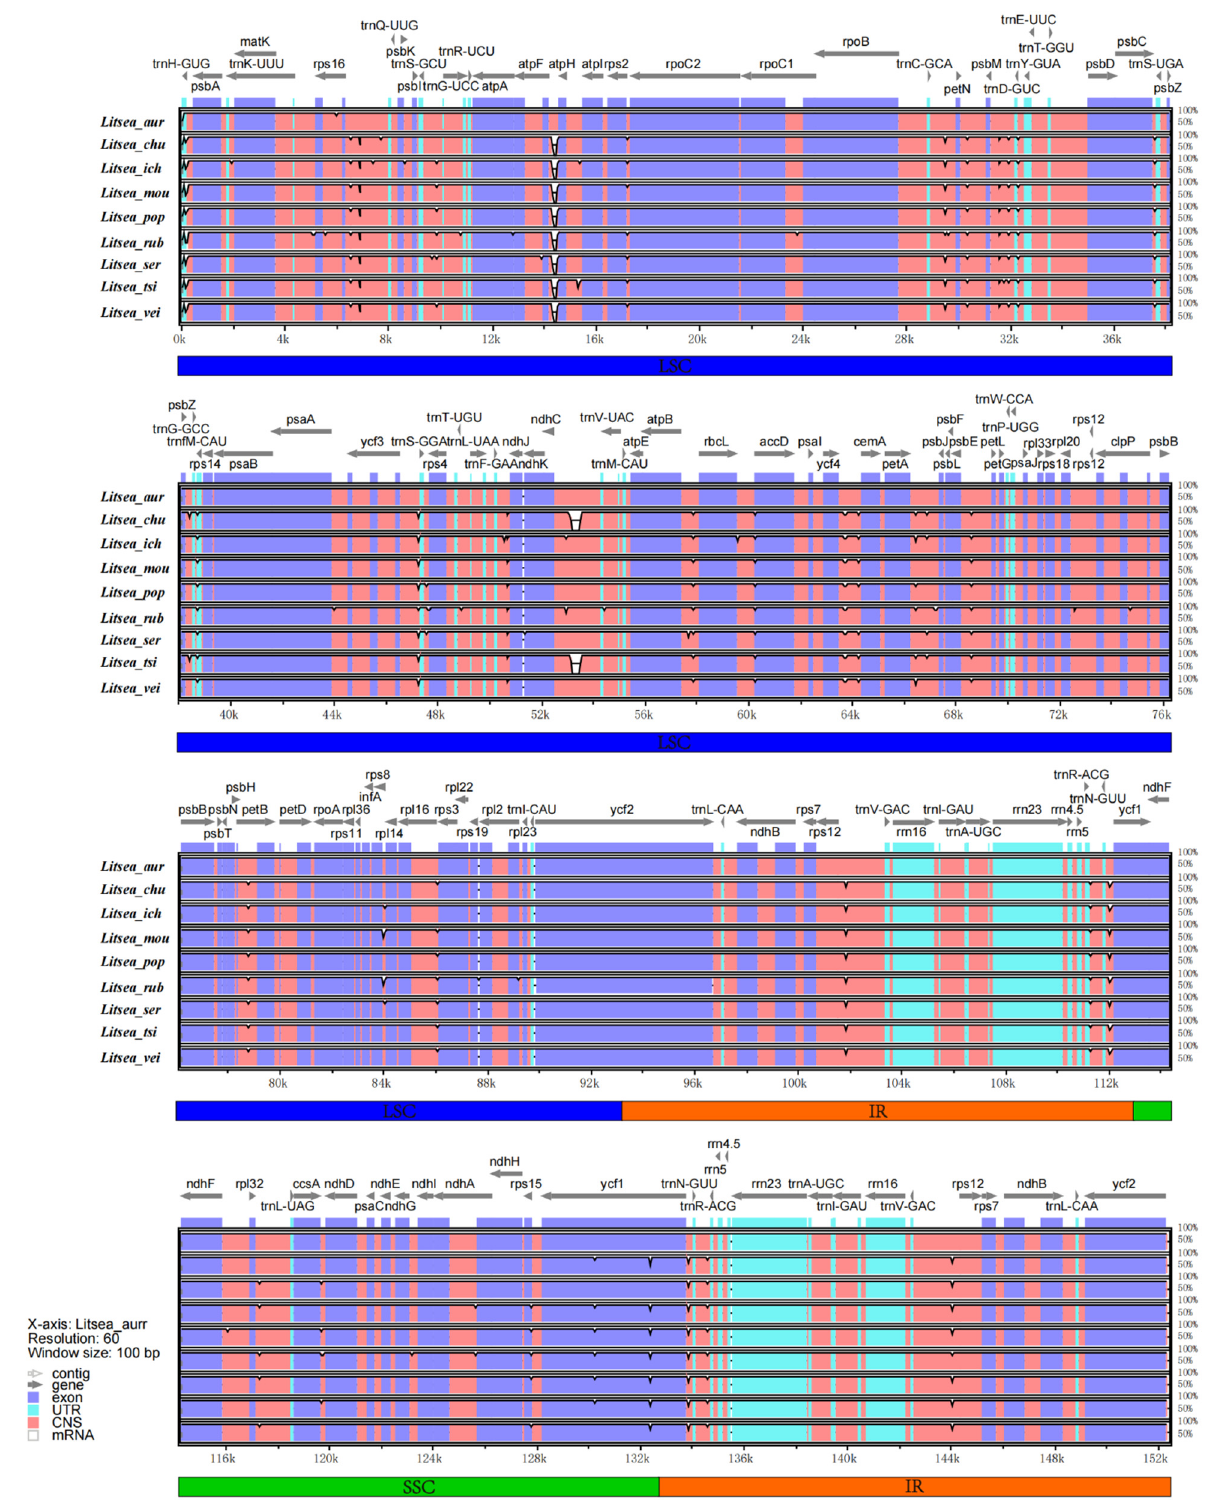
Figure 5. Identification map of chloroplast genome of nine species of Litsea . From top to bottom: L. auriculata , L. chunii , L. ichangensis , L. moupinensis , L. populifolia , L. rubescens , L. sericea , L. tsinlingensis , L. veitchiana . The gray arrows above indicate the extension direction of the gene, and purple indicates the exon, blue indicates the untranslated region, pink indicates the non-coding sequences, and the grayish part indicates mRNA.